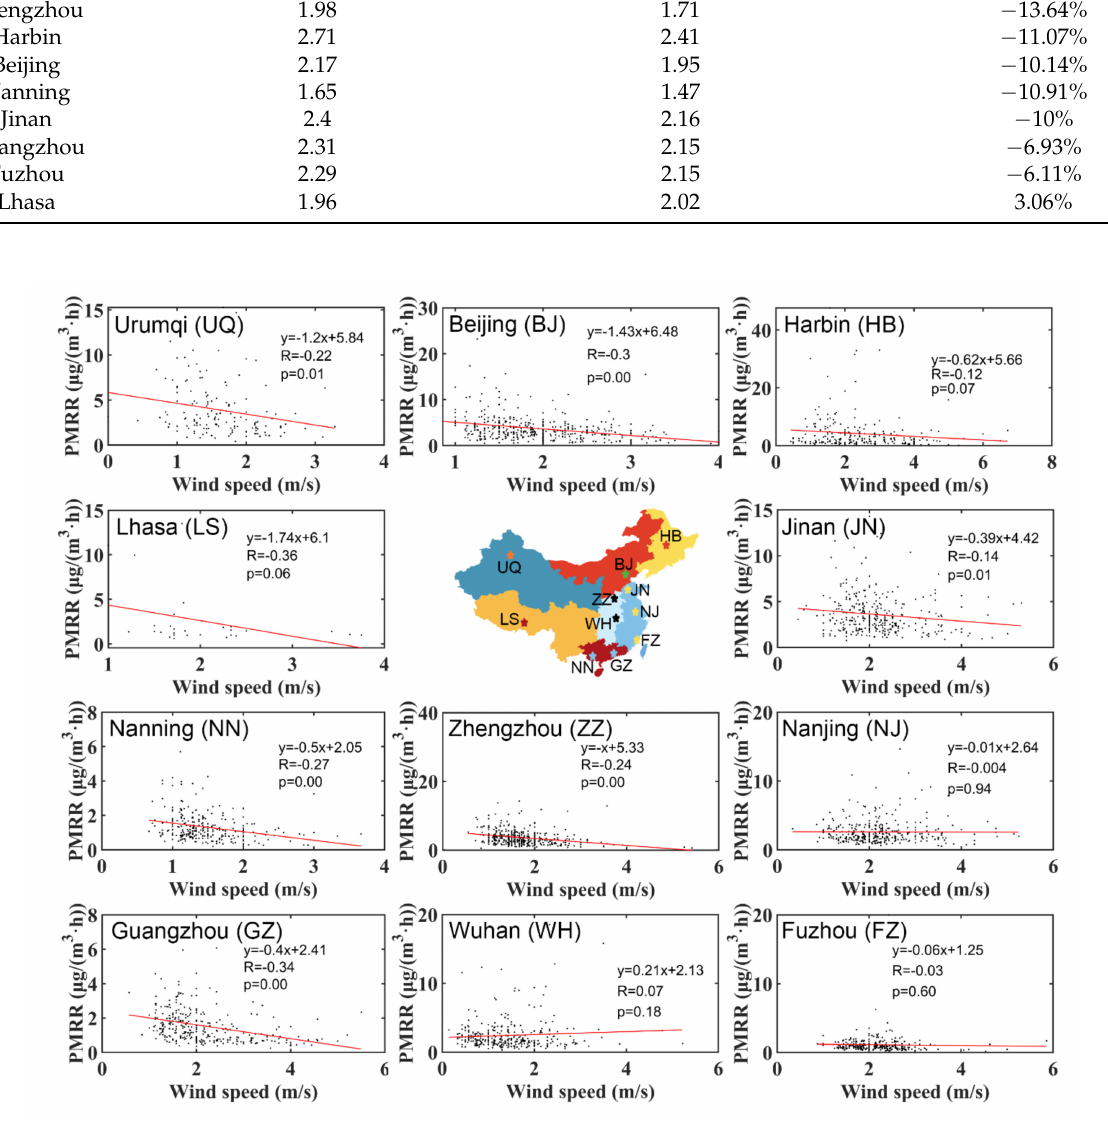
Figure 10. The correlations between PMRR and wind speed in the 11